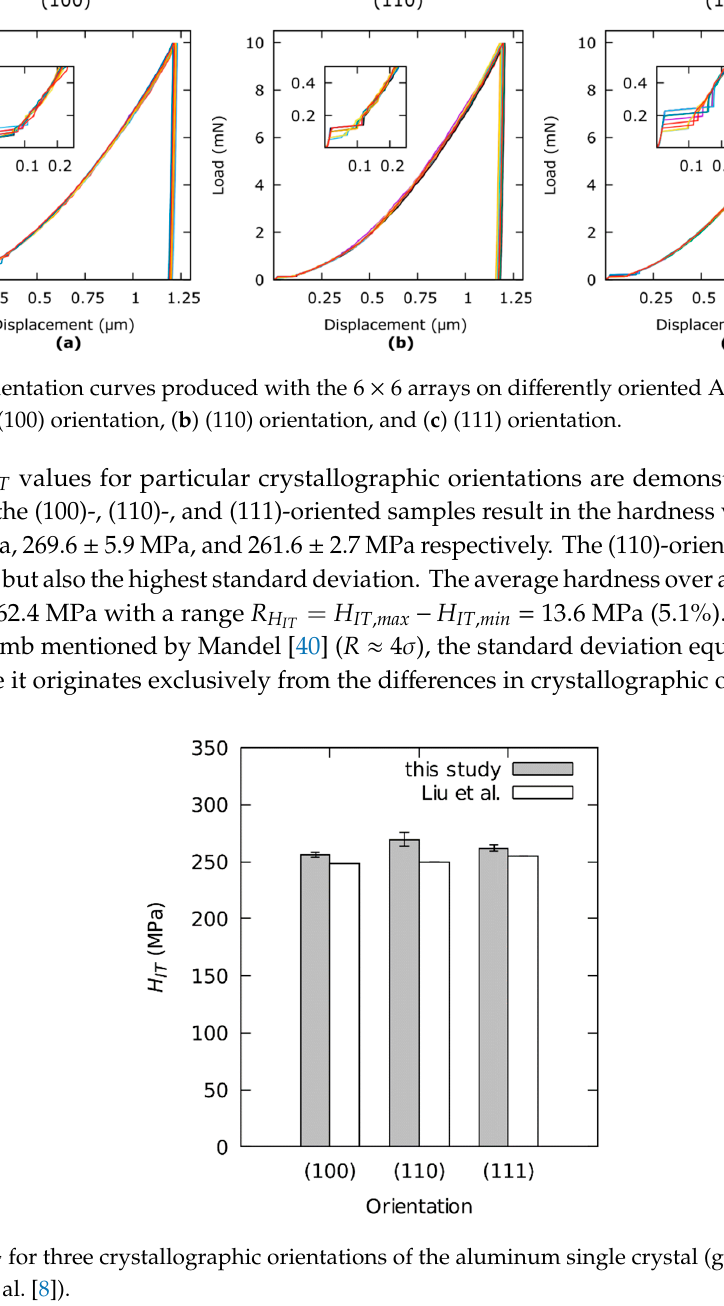
Figure 6. H IT for three crystallographic orientations of the aluminum single crystal (grey: this study, white: Liu et al. [8]).